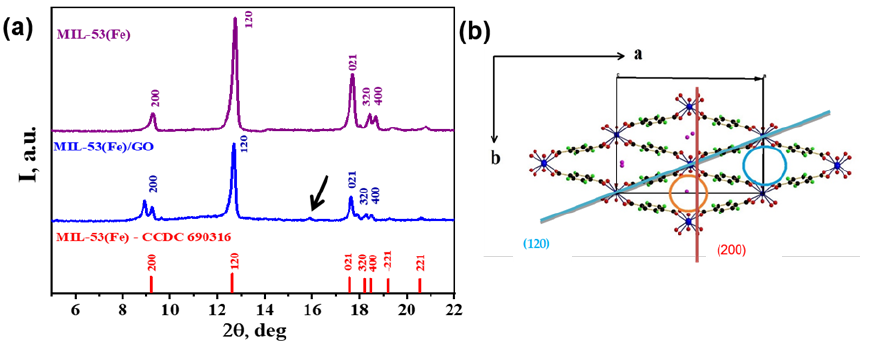
Figure 9. ( a ) Diffraction patterns of samples: MIL-53(Fe), MIL-53(Fe)/GO and theoretical diffractogram (programs Diamond, Mercury); ( b ) model structure V of MIL-53 (M 3+ ) (lt)-Fe(OH)(BDC) 2 − xH 2 O.